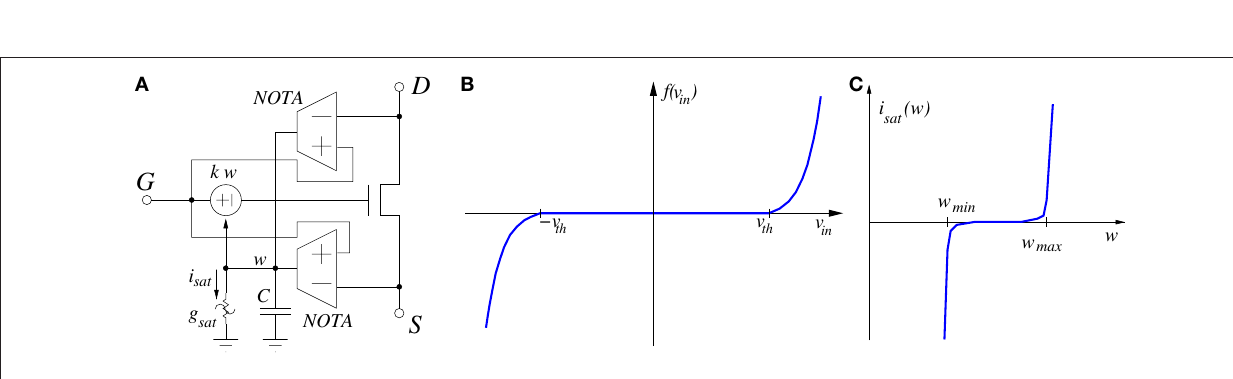
Figure 16 | illustration of 3-terminal FeT. (A) Symbol defining the three-terminals: gate G , drain D , and source S . (B) FET drain-to-source current (in log scale) as function of gate-to-source voltage V for different threshold voltages. GS